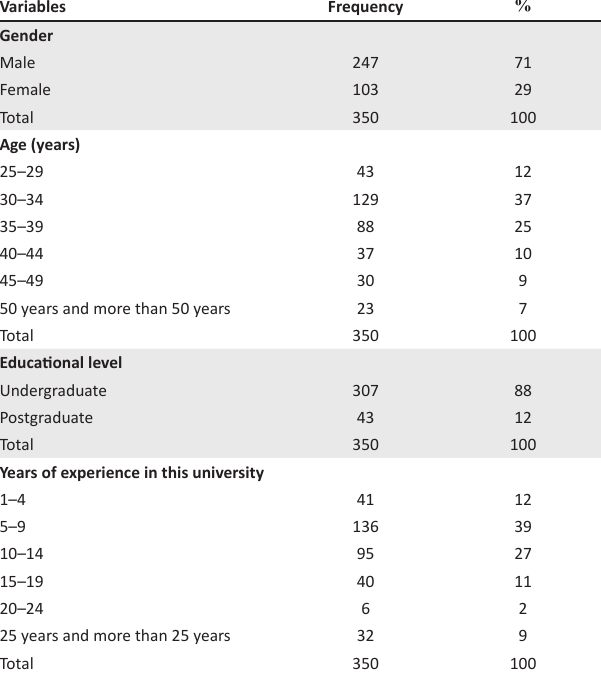
TABLE 1: Demographical characteristics of